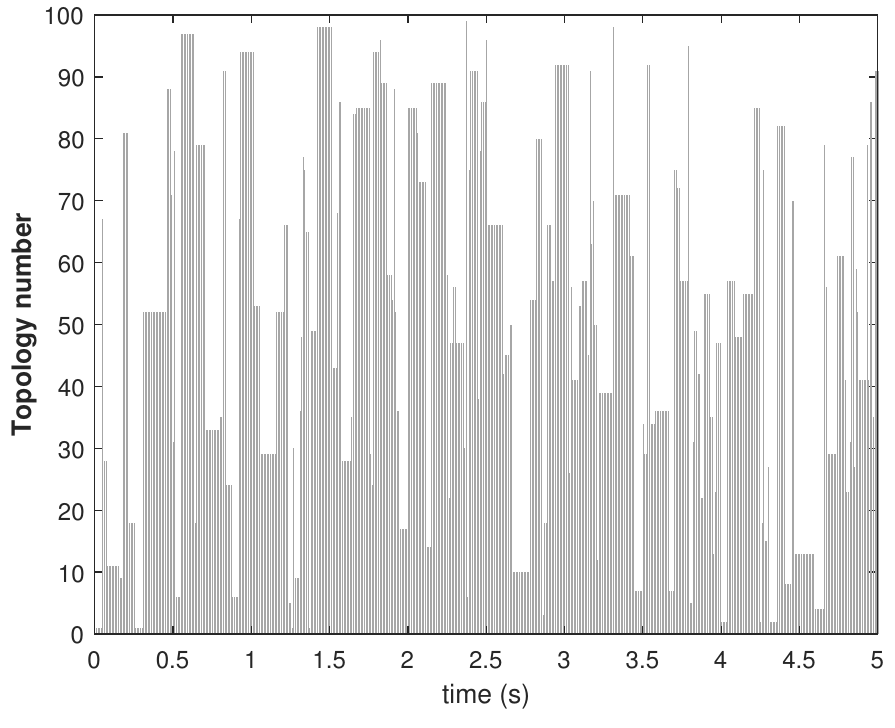
Figure 13. Consensus error E i in state X 1 of agents.